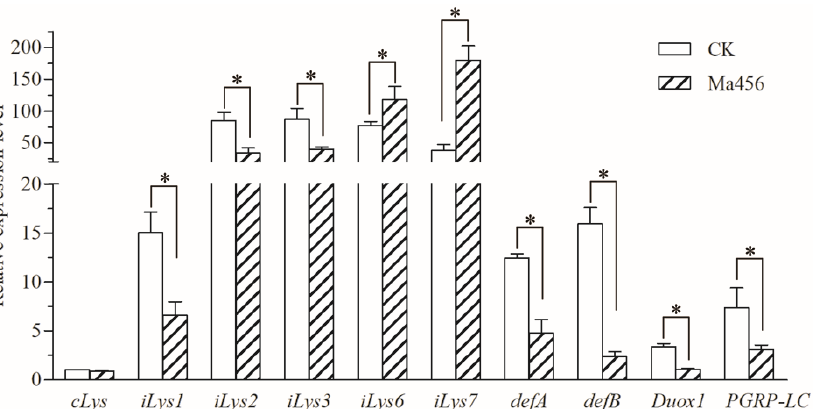
Figure 7. Relative expression levels of ten gut-homeostasis-related genes in the gut of BPH that treated by fungal infection (Ma456) and 0.02% Tween 80 (CK). Asterisk indicates significant difference between two BPH gut samples ( p < 0.05). Error bars: SD from three repeated assays.